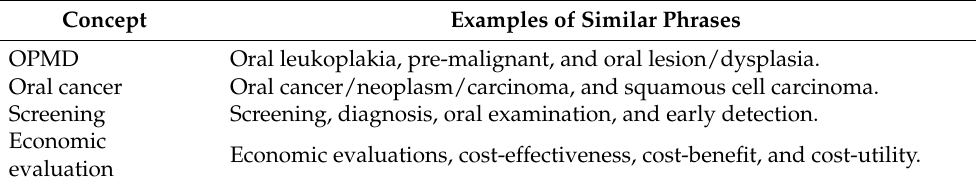
Table 1. Search concepts and examples of phrases used.